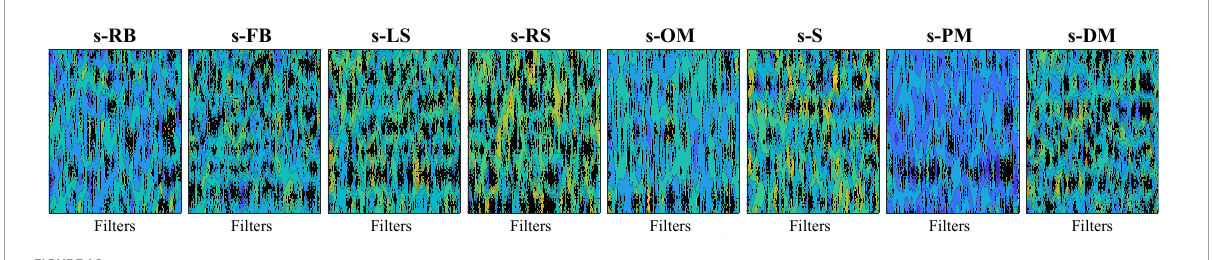
TABLE 13 Confusion matrix among eight slight-facial expression (sFEs). True label Predicted label